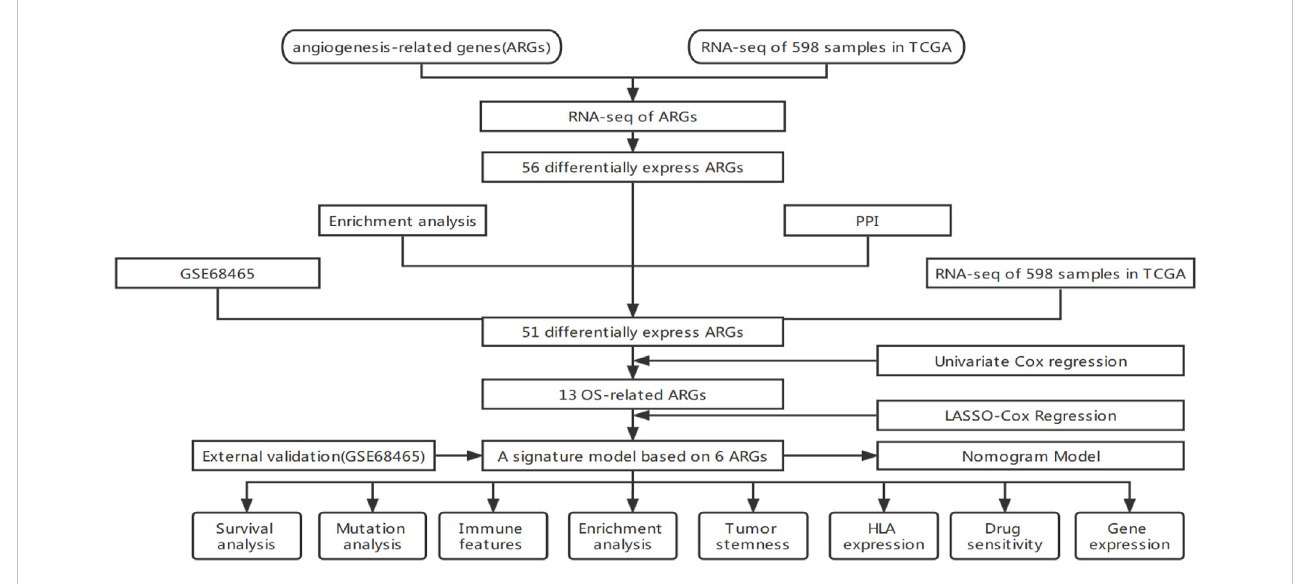
FIGURE 1 Data gathering and processing fl